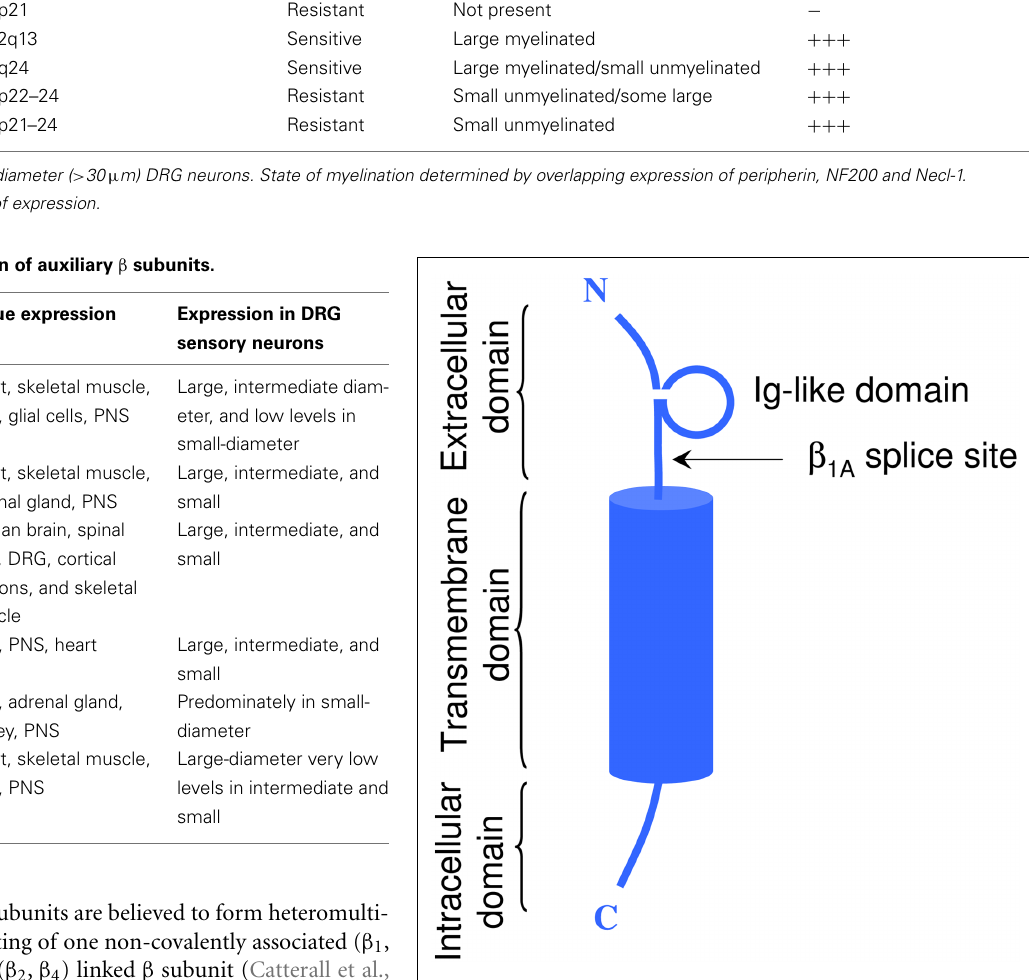
FIGURE 1 | Schematic representation of a typical β subunit, consisting of an NH2-terminal (N) containing an Ig loop and the β 1A splice site, a COOH-terminal (C) and a transmembrane-spanning